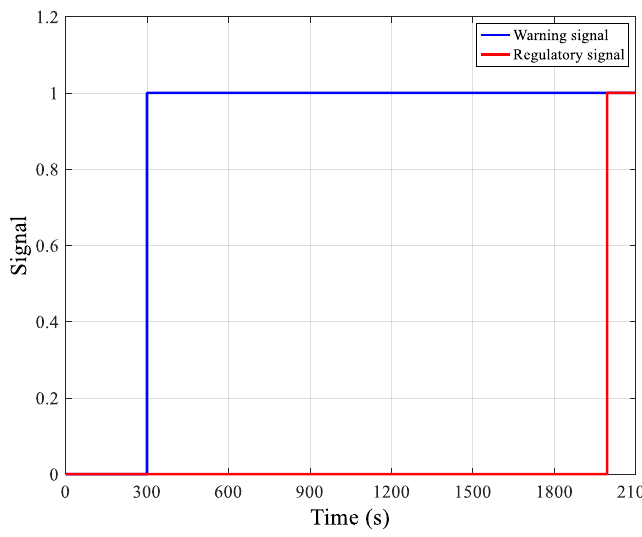
Figure 12. Warning and regulatory signals.